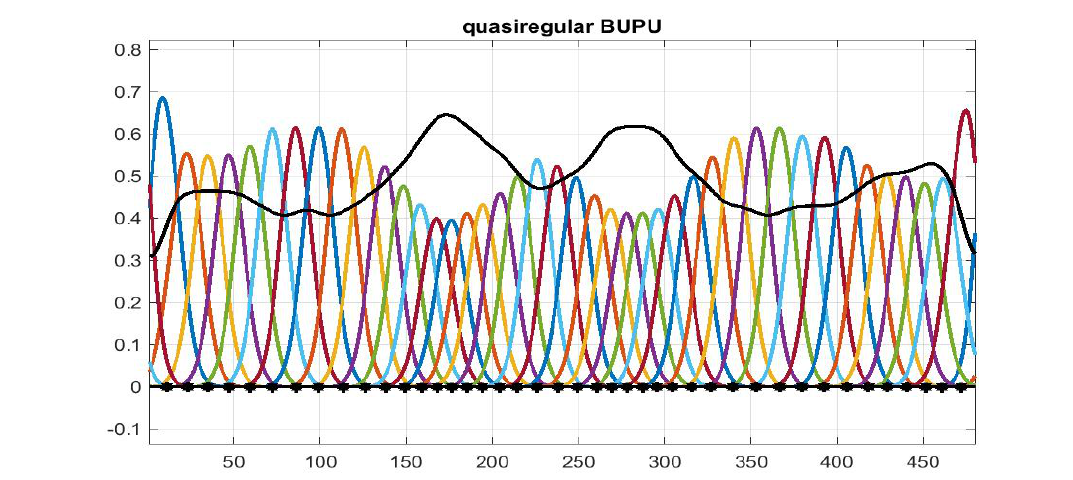
Figure 1. A typical BUPU, illustrating Definition 1, obtained by positioning shifted bump functions at well-spread locations (marked with ∗ ) on the line, followed by a division through the sum of those bump functions, displayed in